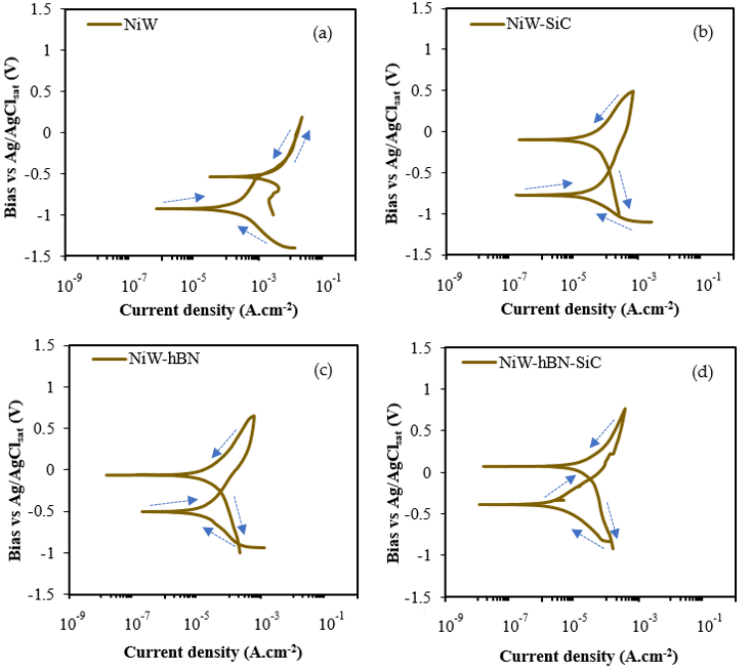
Figure 9. CPP (cyclic potentiodynamic polarization) of a DC electrodeposited: NiW ( a ), NiW–SiC ( b ), NiW–hBN ( c ), and NiW–hBN–SiC ( d ) performed at room temperature ( ∼ 25 °C) and pH of ∼ 8.